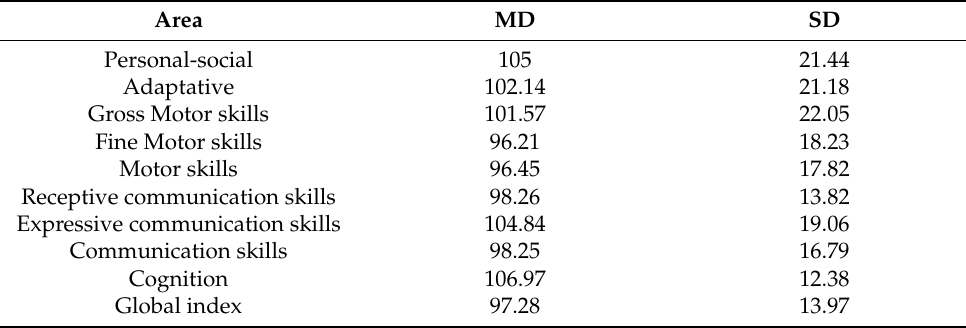
Table 3. Mean of Quotient reached in each development scale for children.